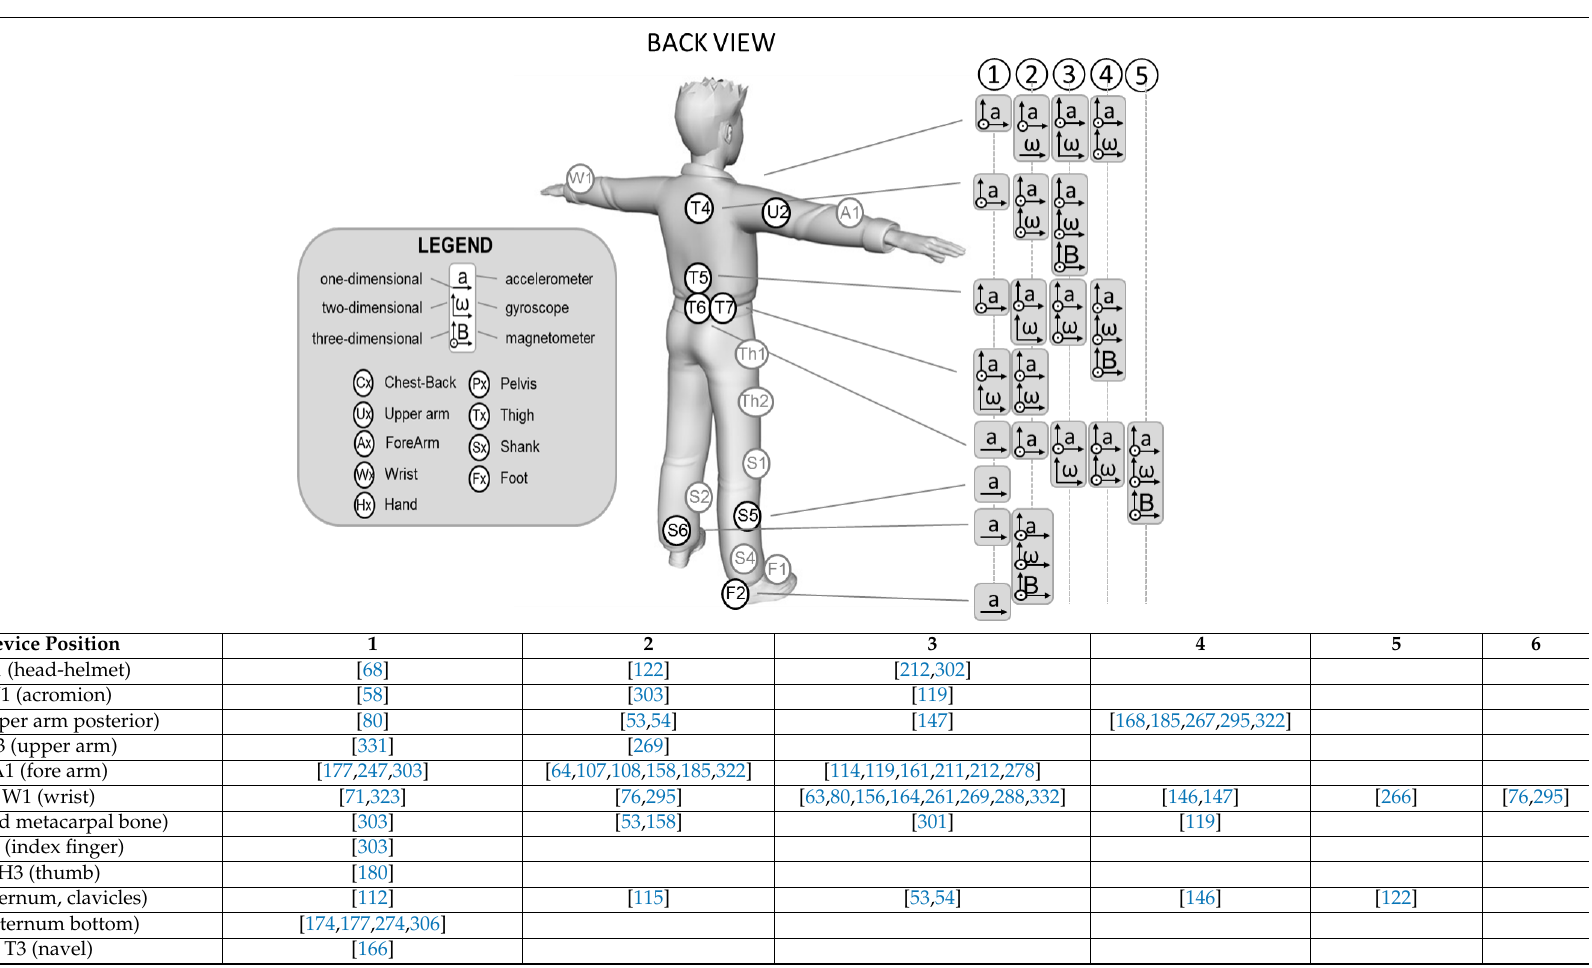
Table 5. Cont. Sensors 2018 , 18 , x FOR PEER